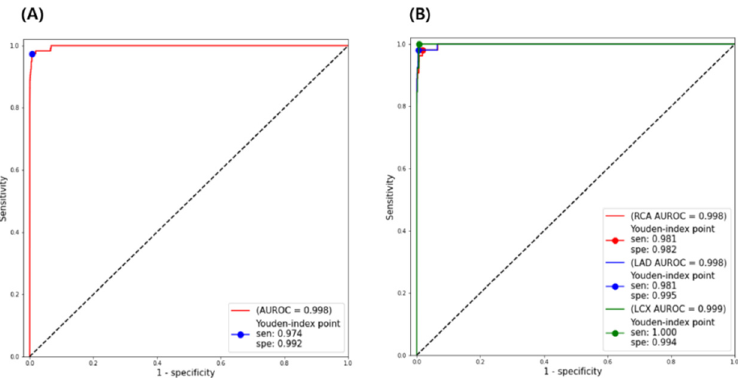
Figure 3. Diagnostic accuracy of the deep learning model for ST elevation myocardial infarction detection compared with normal sinus rhythm. ( A ) Overall accuracy and ( B ) the comparative accuracy according to culprit coronary arteries. STEMI, ST elevation myocardial infarction; ROC, receiver operating characteristic; AUROC, area under the receiver operating characteristic; SEN, sensitivity; SPE, specificity; NSR, normal sinus rhythm; RCA, right coronary artery; LAD, left anterior descending artery; LCX, left circumflex artery.